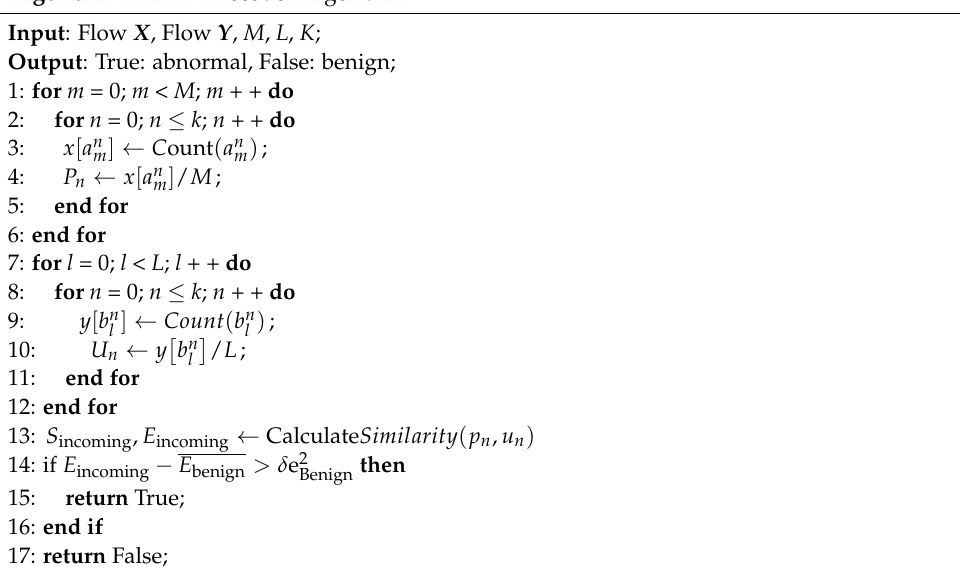
Algorithm 1 MFPK Precoder